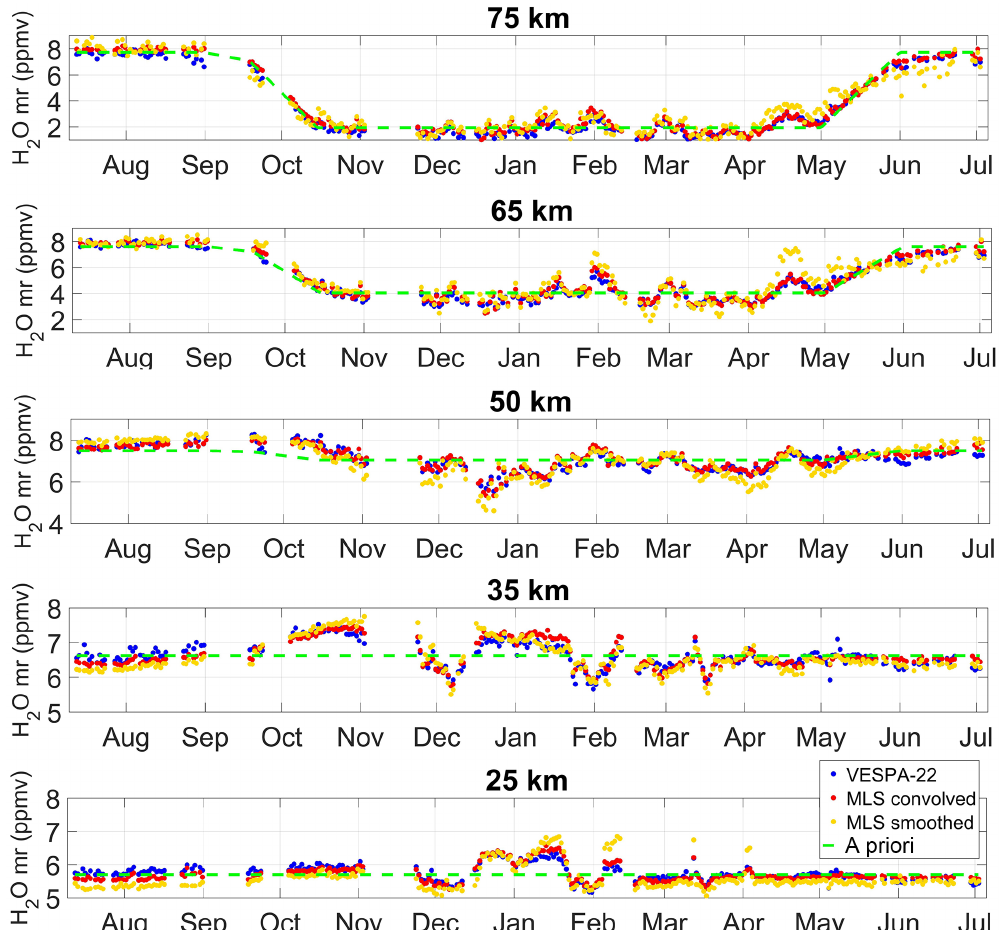
Figure 14. Time series at different altitudes of water vapor mixing ratio values obtained with VESPA-22 (blue), by convolving MLS HR vertical profiles with VESPA-22 averaging kernels (red), and by smoothing MLS HR vertical profiles with a 10km running average (yellow). Please note that the time series at the five different altitude levels have different scales on the y axis in order to better show the differences between